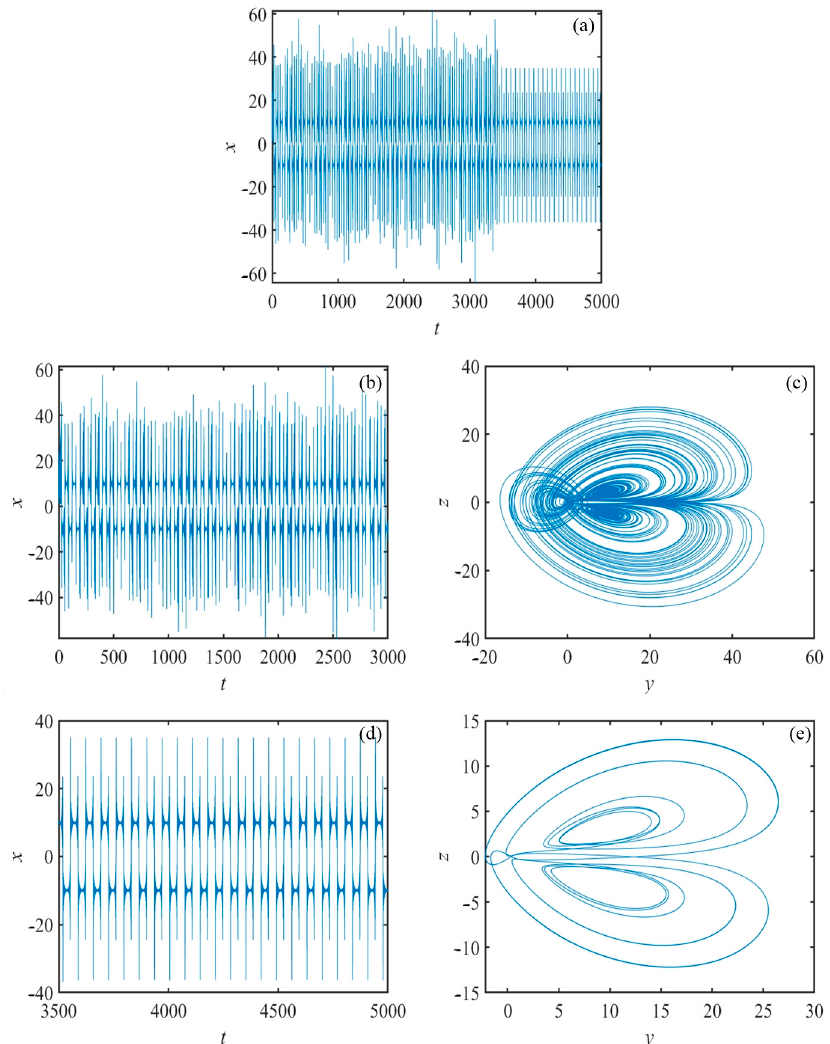
Figure 6. ( a ) time-domain waveform when t ∈ [0, 5000] ( b ) time-domain waveform when t ∈ [0, 3000] ( c ) chaotic attractor with t ∈ [0, 3000] ( d ) time-domain waveform when t ∈ [3000, 3500] ( e ) chaotic attractor with t ∈ [0, 3000].